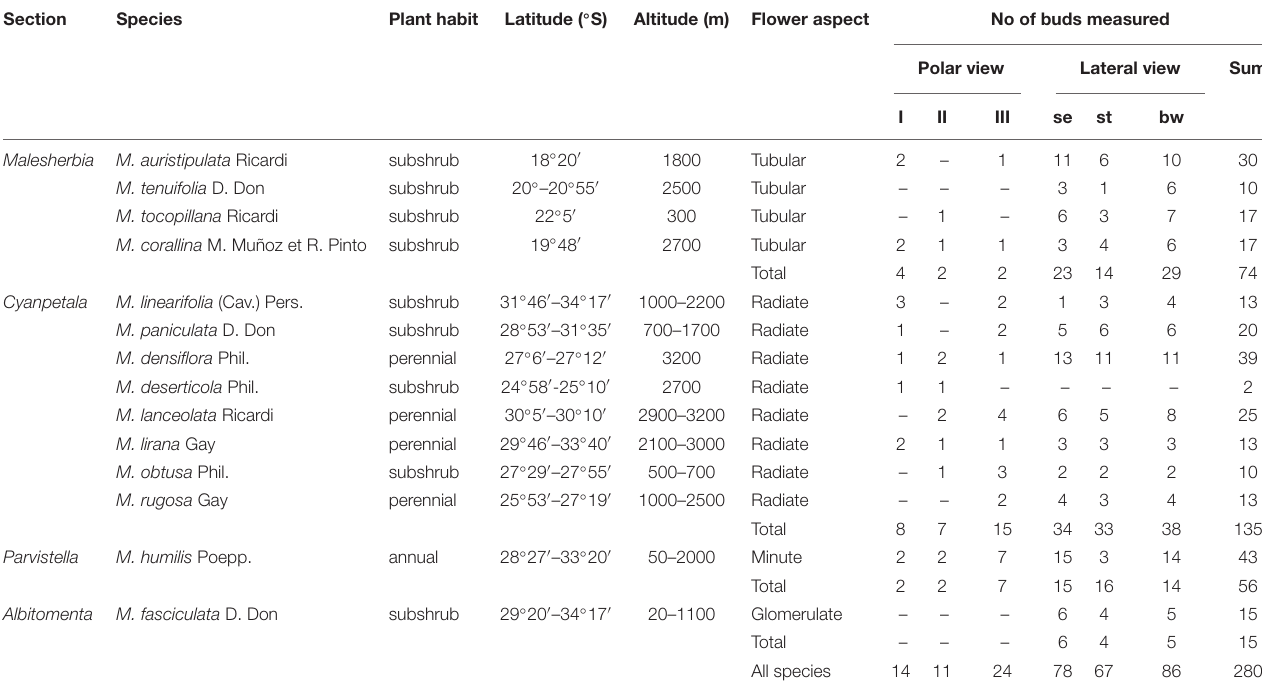
Roman numerals under Polar view indicate developmental stages and abbreviations under lateral view refer to measurements taken. See section “Materials and Methods” and Figure 2 for more details. se = sepal, st = stamen, bw = bud width.